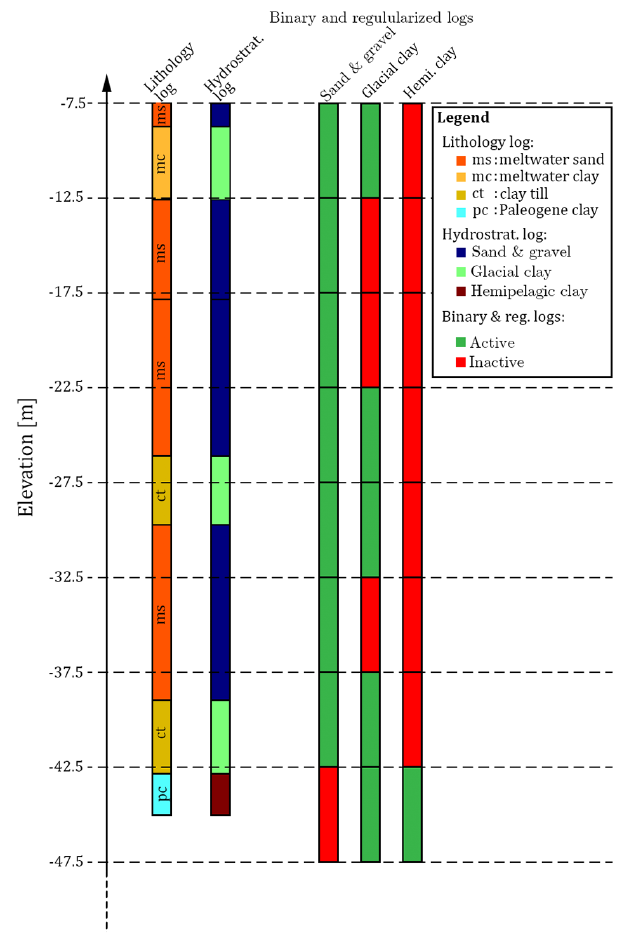
Figure 7. An example of how a single lithology log is categorized and sorted for the purpose of calculating the borehole distance. The first step is to translate the raw lithology log into a hydrostrati- graphic log, which is achieved by categorizing the multiple litholog- ical categories into a subset of three hydrostratigraphic categories corresponding to the target categories we wish to model. Note that some categories do not fit into the overall hydrostratigraphic cat- egories and are therefore not translated, e.g., the meltwater sand category in this example. The final step is then to assign the hydros- tratigraphic logs to the regularized sampling grid and create one binary log for each of the three target modeling categories. This is done by simply asking whether or not the given hydrostratigraphic category is present (true) or not (false) for the given sampling grid